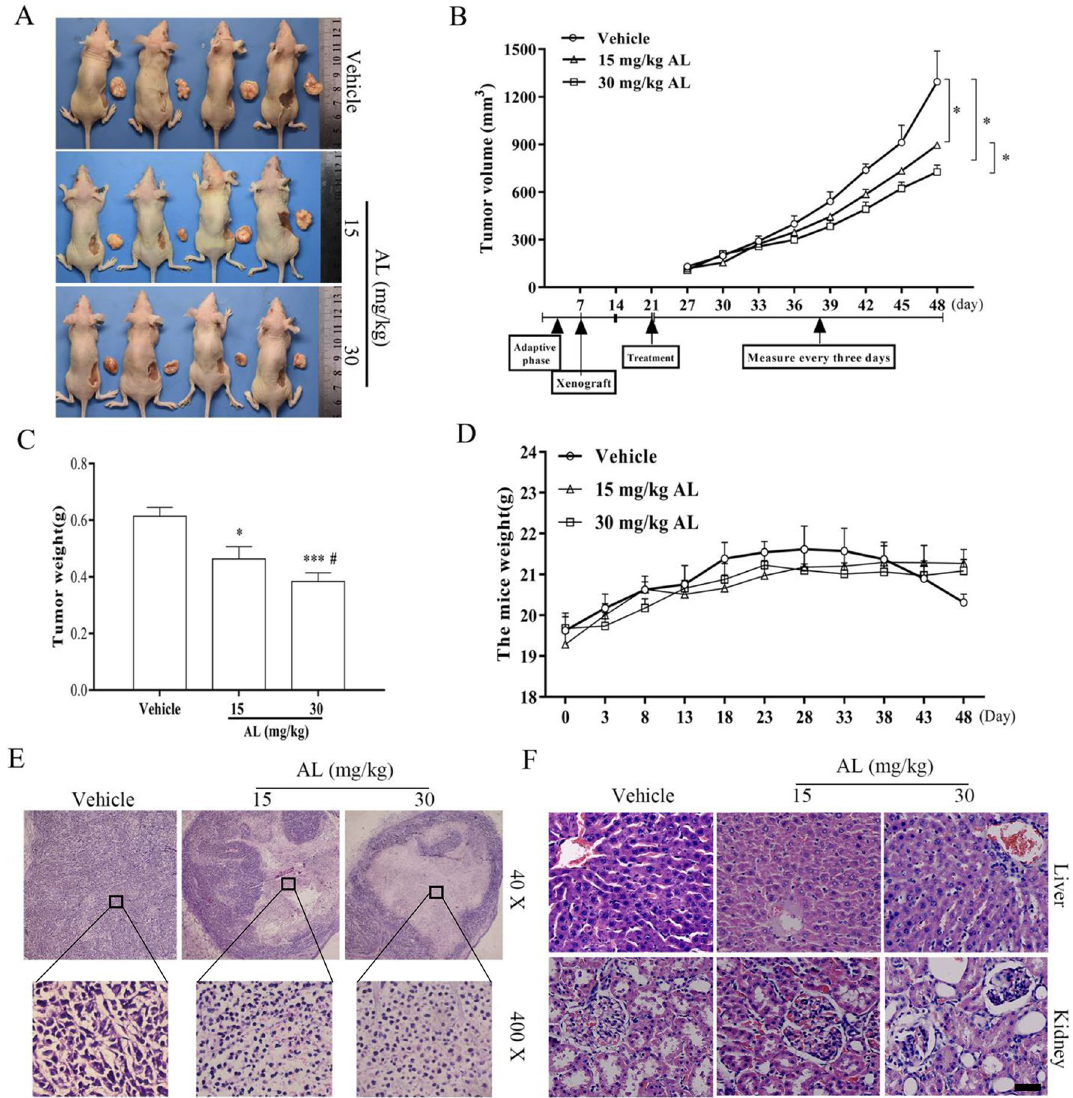
Figure 5. AL inhibited the growth of mouse cervical cancer xenografts model established with HeLa cells. ( A , B ) Tumor volumes, ( C ) tumor weights and ( D ) body weights of tumor-bearing nude mice in AL group and control groups. * P < 0.05, *** P < 0.001, vs vehicle group. # P < 0.05, vs AL 1 5 mg/kg group. ( E ) Morphology of tumor xenograft from each mouse. ( F ) H&E staining of main organs of tumor-bearing nude mice after treatment. Scale bar: 25